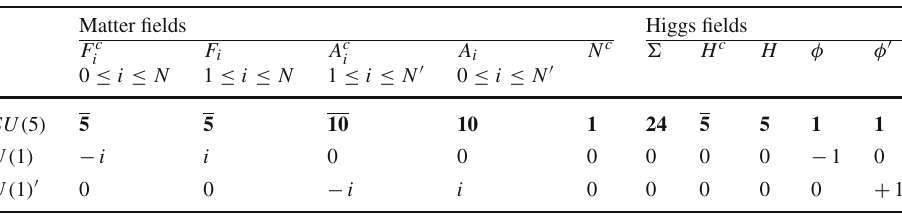
symmetries of the model. All matter fields and their